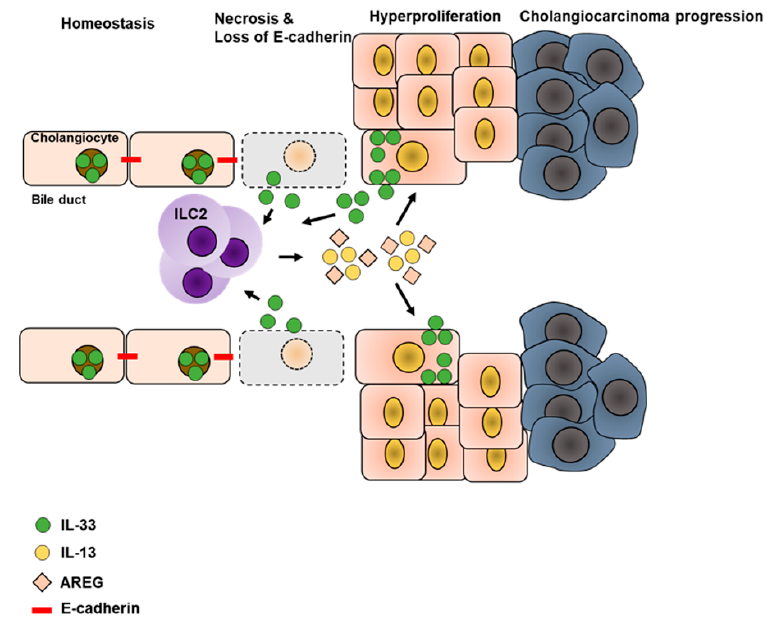
Figure 4. Hepatic ILC2s contribute to the progression of cholangiocarcinoma in extra hepatic bile ducts. Loss of E-cadherin on cholangiocytes and enhanced cellular necrosis favor activation of hepatic ILC2s in an IL-33-dependent manner, thereby promoting expression of IL-13 and AREG. IL-13 and AREG induce hyperproliferation in cholangiocytes and enhanced expression of IL-33, inducing the ongoing activity of ILC2s that favor malignant transformation and progression of cholangiocarcinoma.